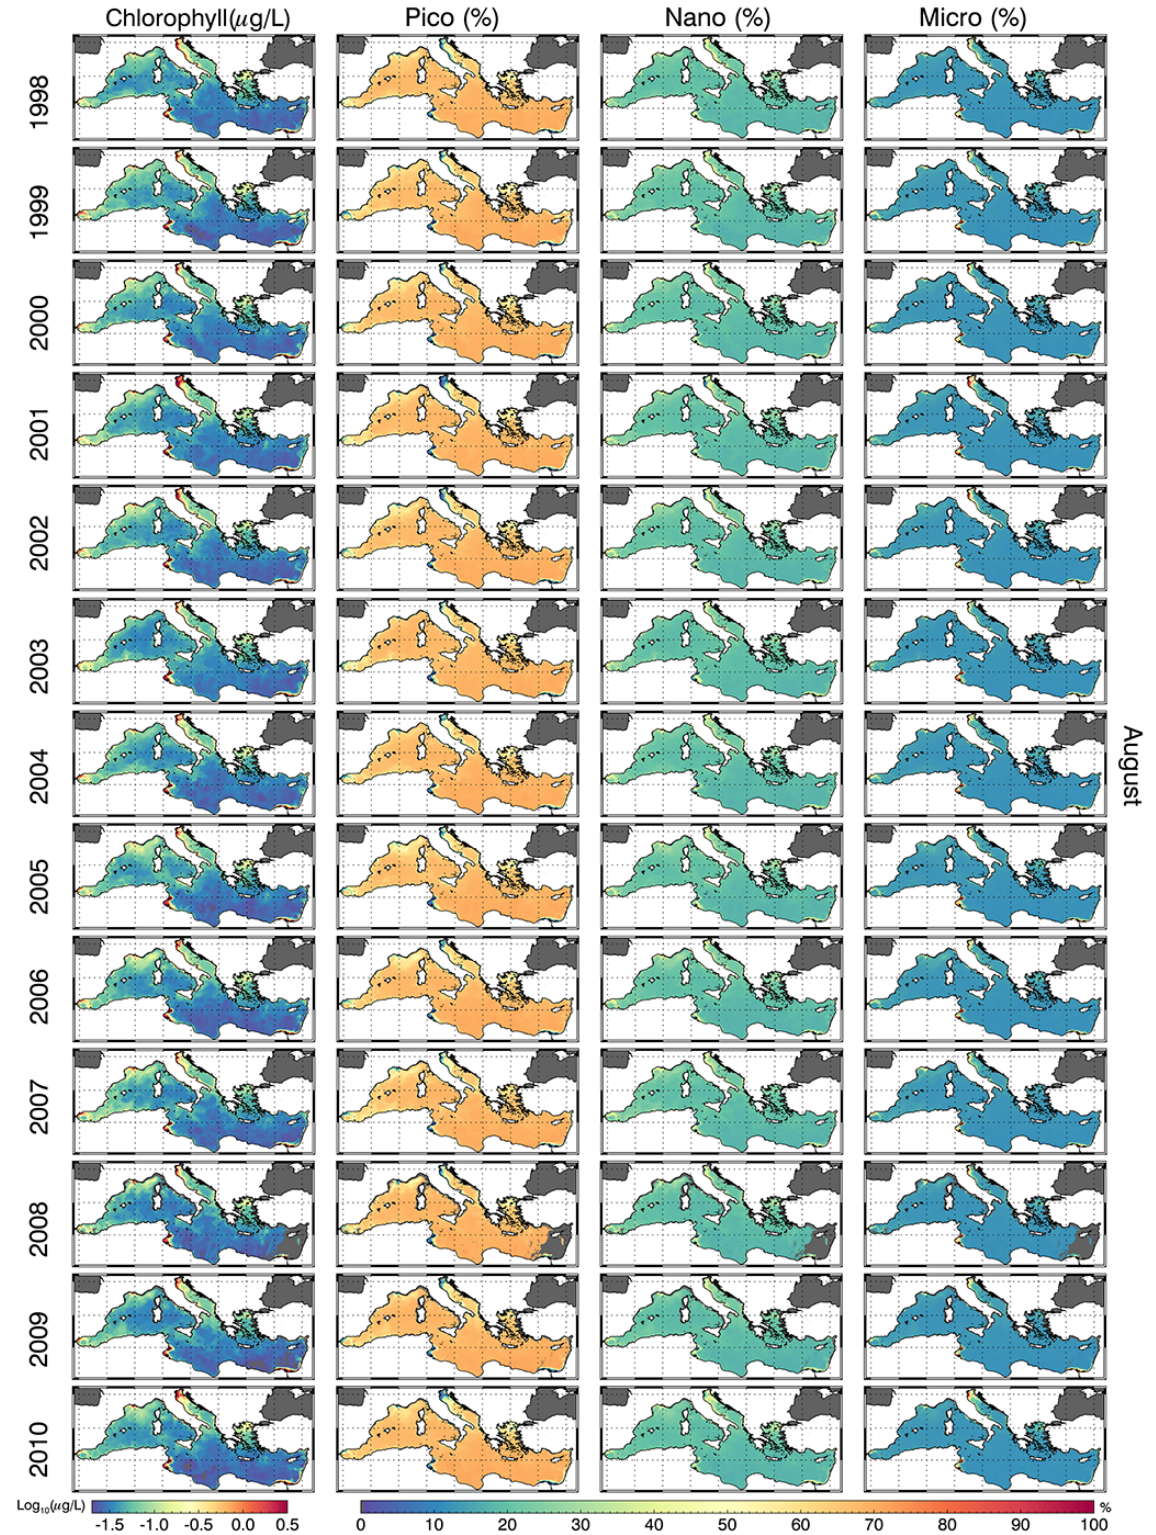
Figure 7. Monthly maps of inter-annual variability (1998–2010) of TChl a and PSCs over the entire basin for August. The first panel refers to TChl a (µgL − 1 ) , the second to the pico-phytoplankton fraction on TChl a (%), the third and the fourth, respectively, refer to the nano- and micro-phytoplankton fractions